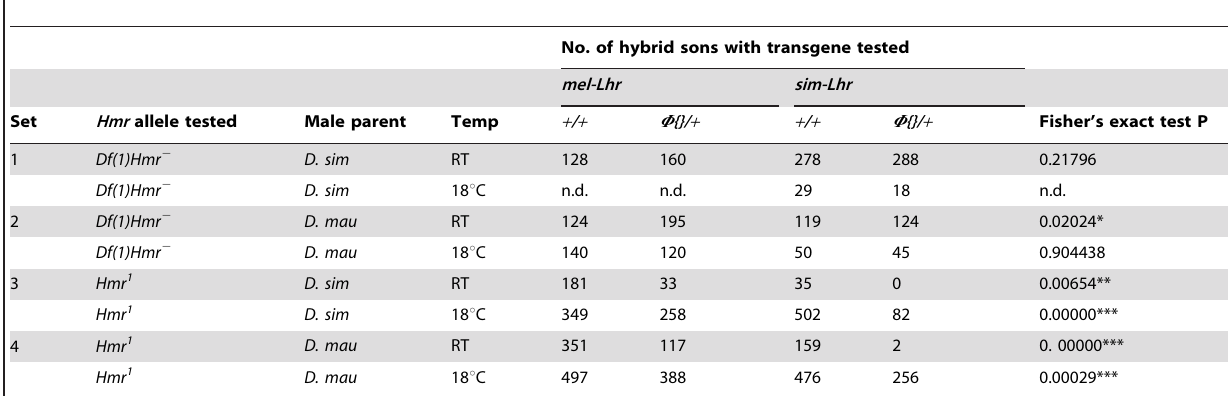
Table 2. D. simulans Lhr interacts more strongly with Hmr than D. melanogaster Lhr .